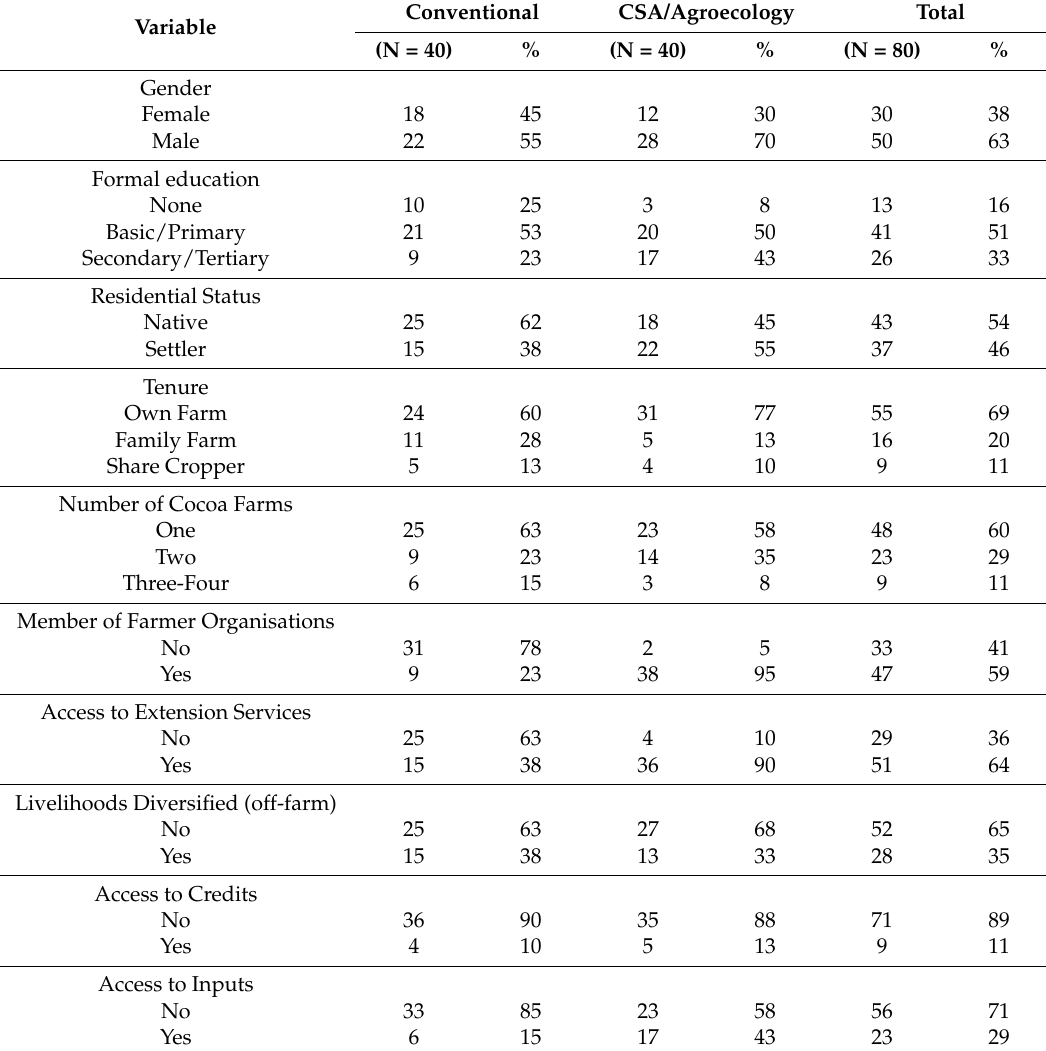
Table 4. Characteristics of Cocoa Farming Household